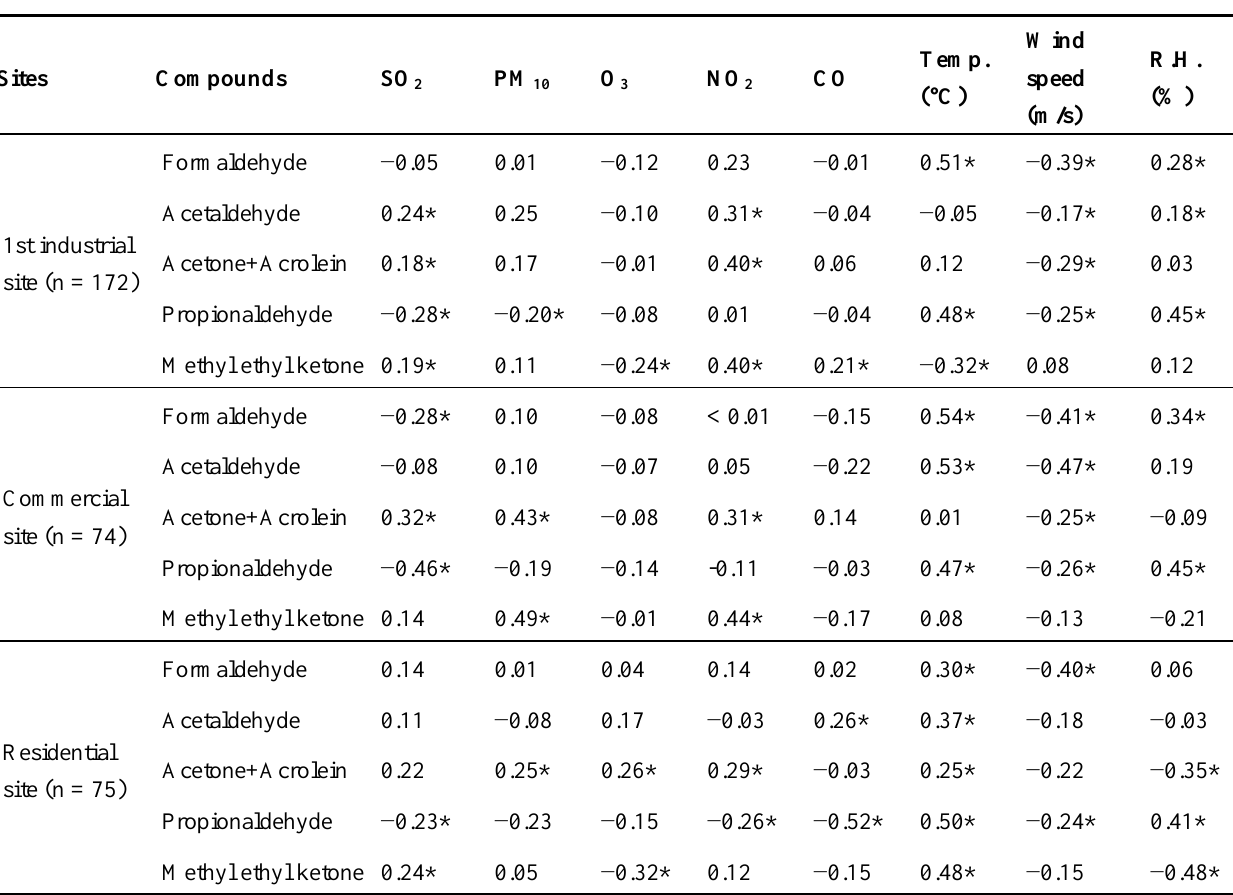
Table 7. Pearson correlation coefficients between carbonyl compounds and other air quality